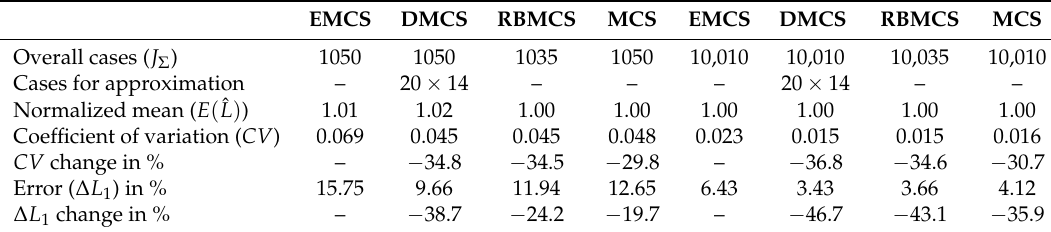
Figure 9. Convergence of the five sampling concepts using measurement data of D06. ( a )Lifetime mean value errors ( ∆ µ ). ( b )Lifetime 1% error ( ∆ L 1 ). ( c )Lifetime coefficient of variation ( CV ). Table 2. Errors and uncertainties in lifetime using different concepts and 1000 as well as 10,000 overall samples; measurement data of H05. Changes (of CV and ∆ L 1 ) refer to the reference approach